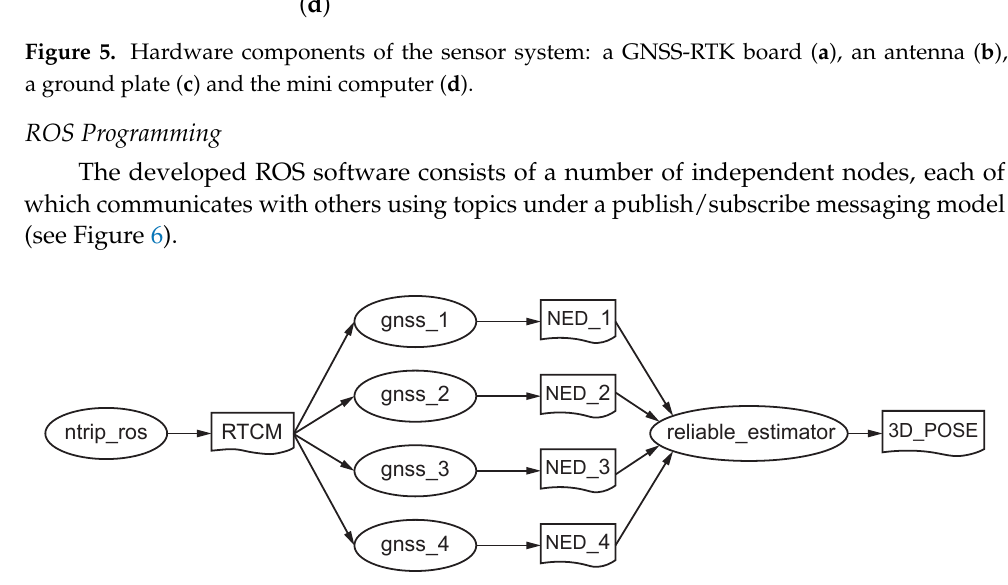
Figure 6. ROS computation graph with nodes (ellipses) and